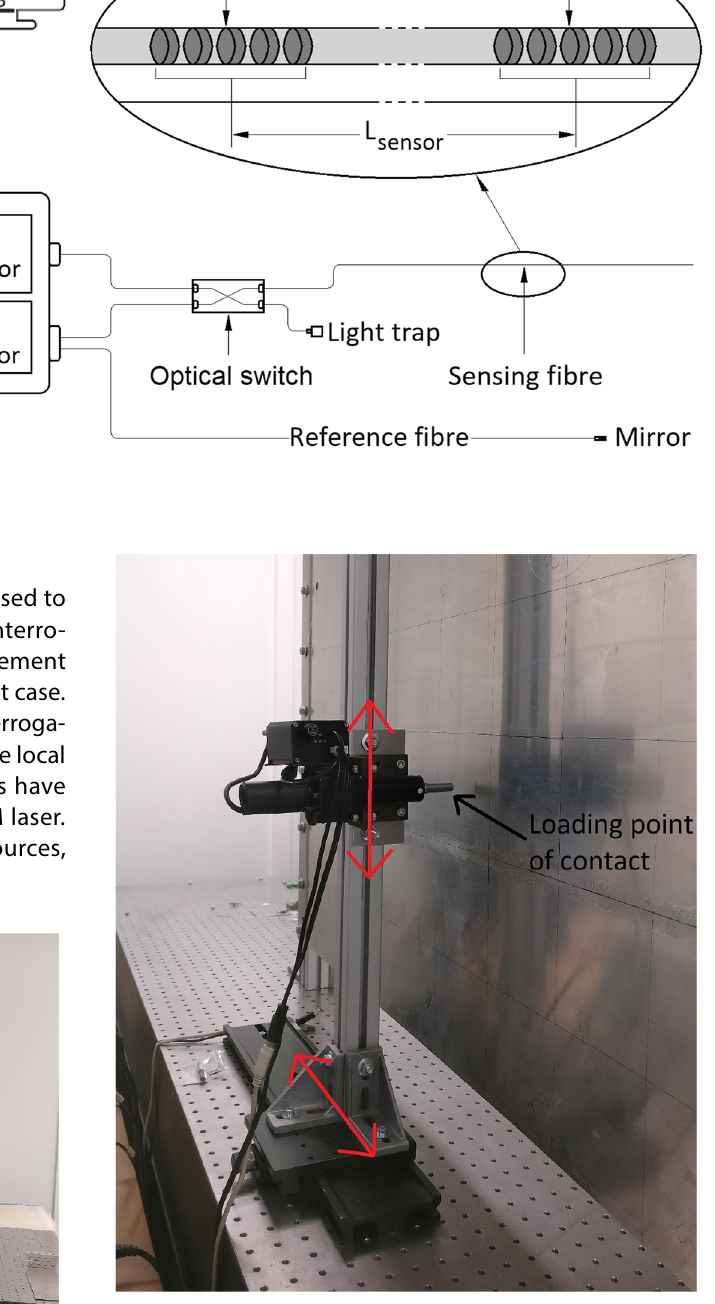
Fig. 5 Schematic of the experi- ment including the two inter- rogators, the sensing fibre and the reference fibre. Zoomed in: Structure of the sensing fibre containing gratings S1 or S4 and S2 or S3 as reflectors. The distance between the grating pairs is marked as L sensor